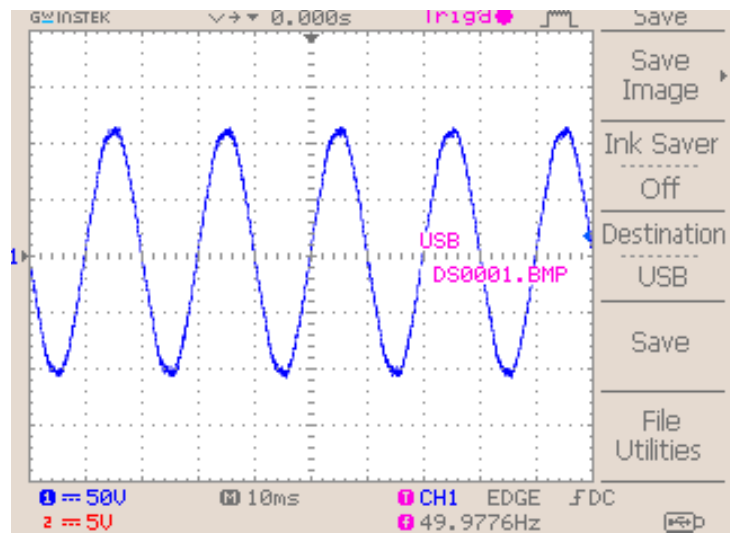
Figure 19. Load voltage waveform.